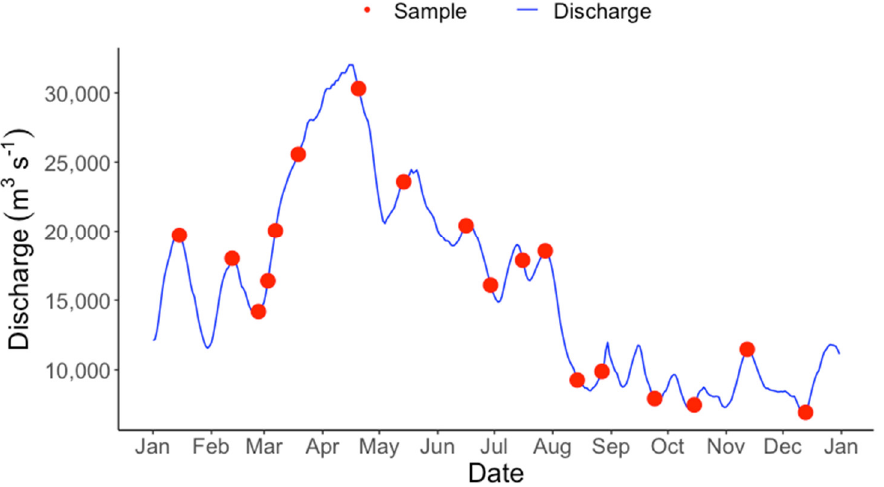
Figure 1. Discharge of the Mississippi River at Study site (USGS # 07374000) over study period January–December 2021. Red dots represent sample dates.